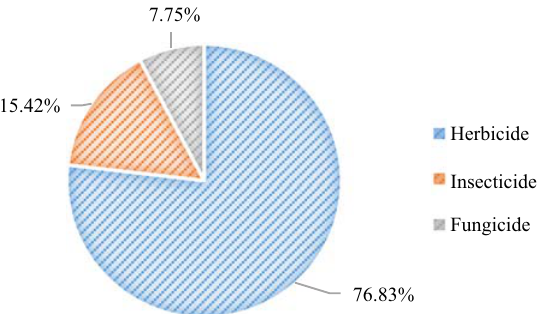
Figure 3. Percentage